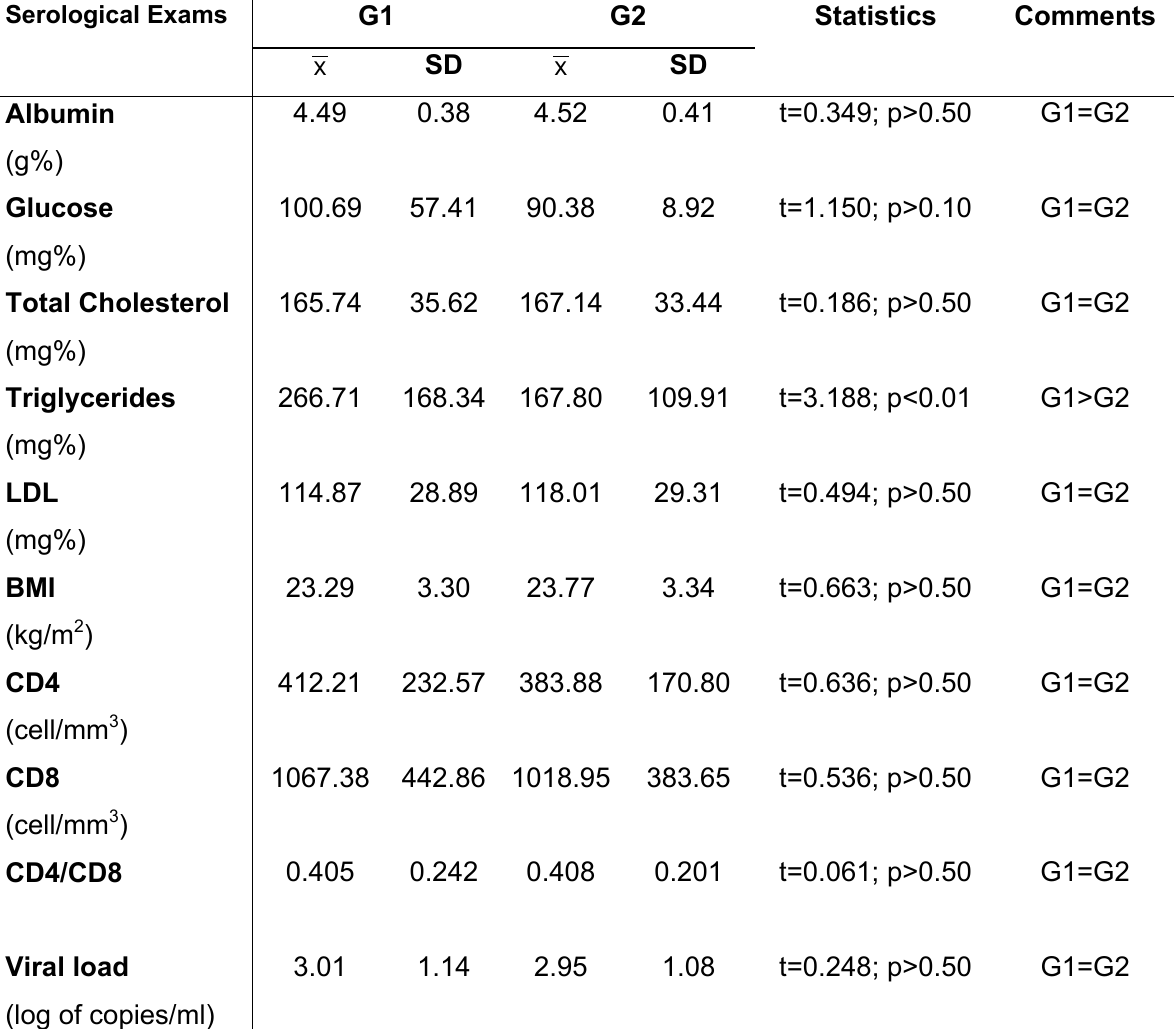
Table 2. Mean ( x ) and Standard Deviation (SD) of biochemical parameters, CD4 and CD8 T lymphocyte counts and body mass index of 84 HIV-1 infected individuals, according to